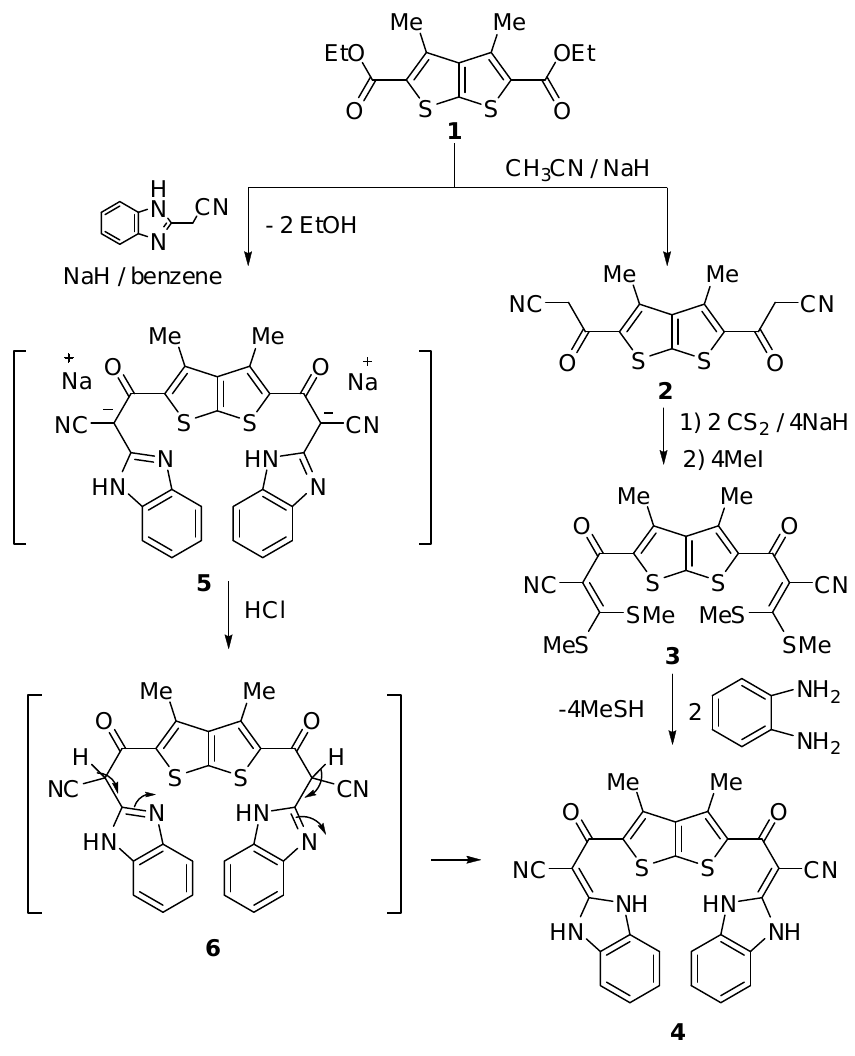
Scheme 2. Synthesis of